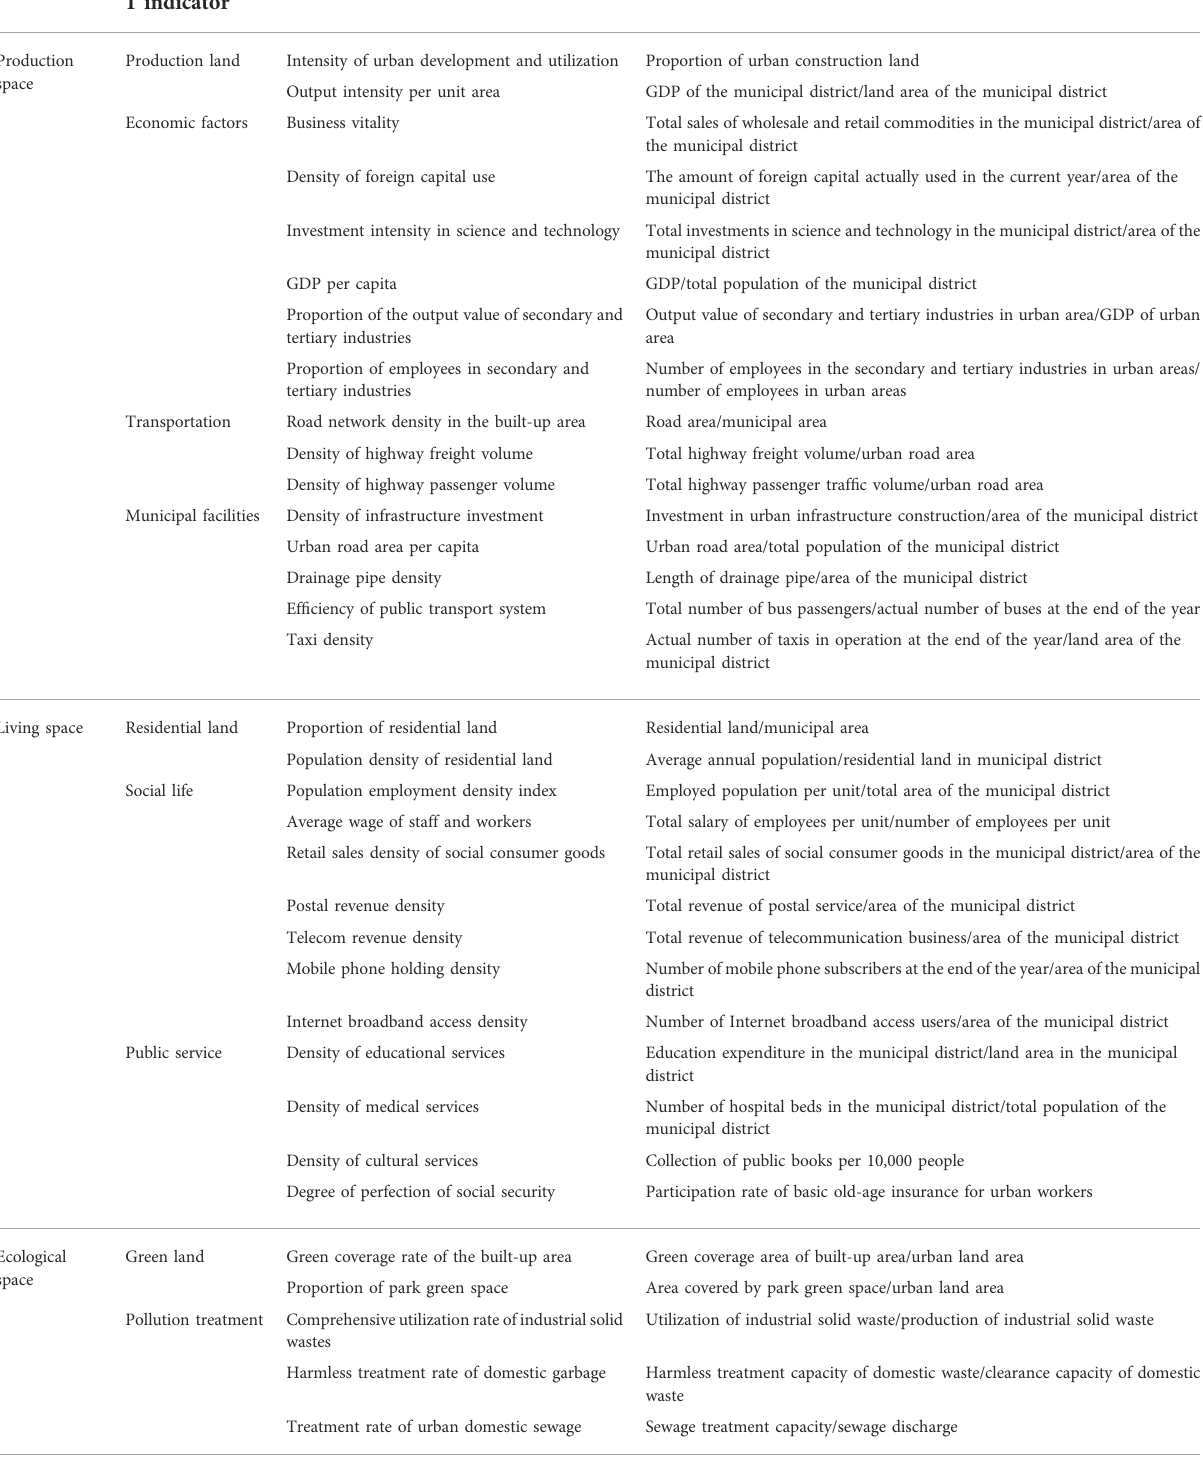
TABLE 1 Index system of degree of compactness in the Jingjinji urban